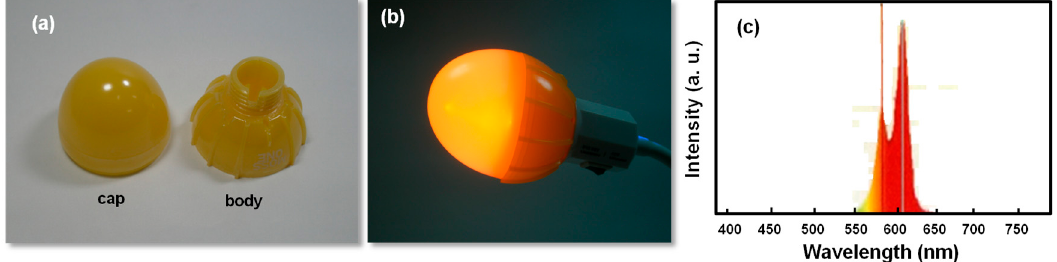
Figure 10. ( a ) LED lamp cap and body, ( b ) assembled LED lamp kit, and ( c ) emission spectrum of the LED lamp.